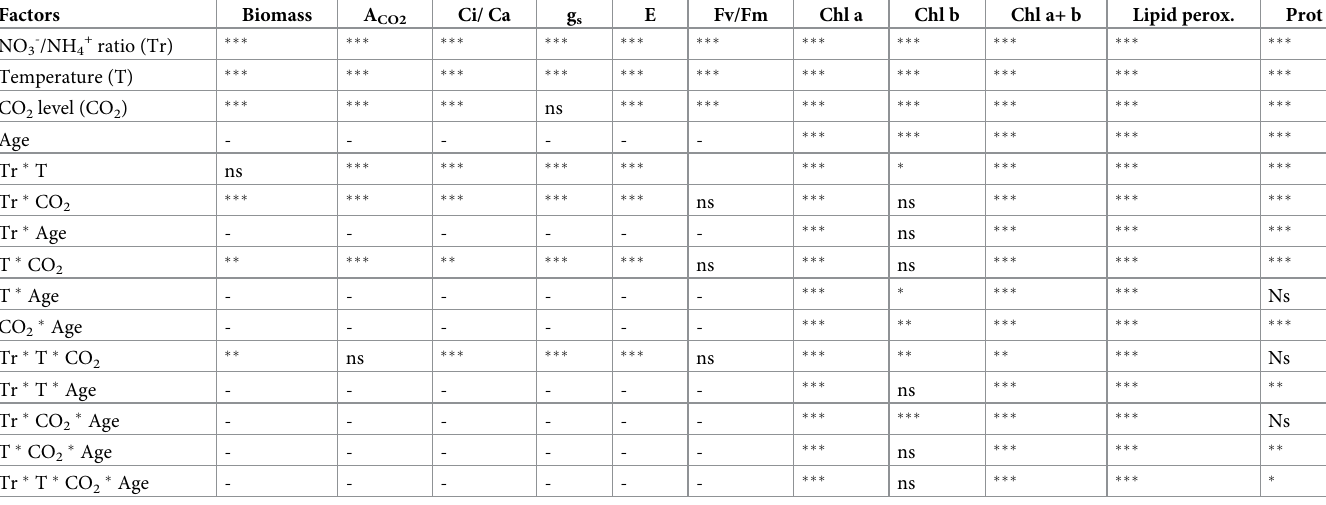
Table 1. ANOVA analysis of how affect the level of CO 2 , short-term heat stress and different NO3-/NH4+ ratios in the nutrient solution on photosynthetic parame- ters, chlorophylls, lipid peroxidation and proteins and the effect of this factors together with leaves age on chlorophylls, lipid peroxidation and